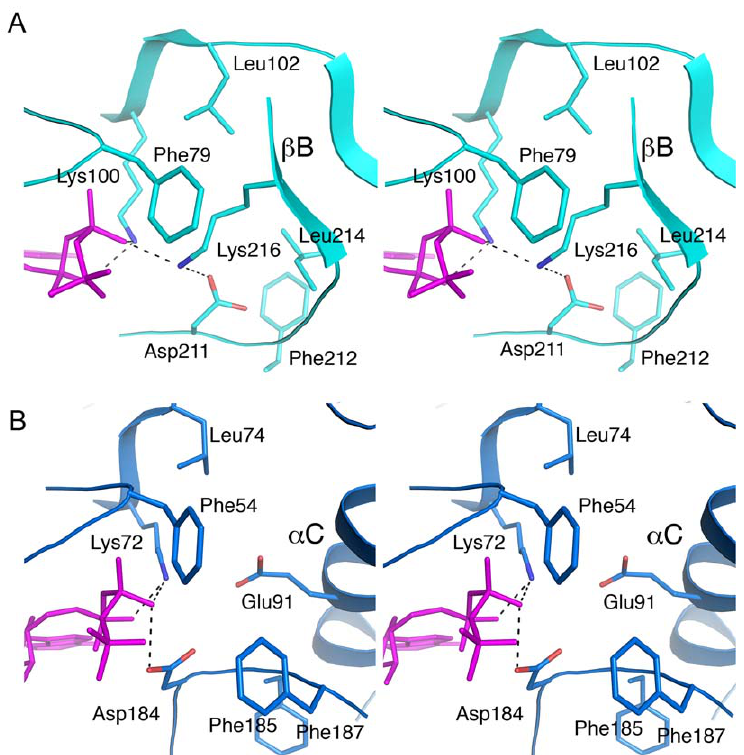
Figure 6. The hydrophobic patch and role of Lys216. The stereo view of the hydrophobic patch formed deep inside the N-lobe and lined by hydrophobic residues is shown for NTD RSK2 in cyan ( A ), and in blue for PKA (PDB code 1ATP) ( B ). The AMP-PNP molecule is shown in magenta. Lys216, located on the b 9-strand of the activation segment and interacting with the b -phosphate and Asp211, introduces a charge to the cavity similar to Glu91 PKA